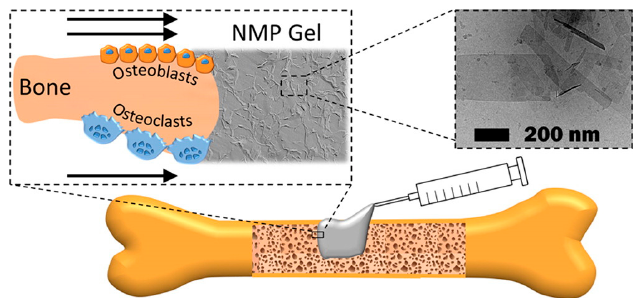
Figure 14. Schematic representation of a nanocrystalline magnesium phosphate (NMP) hydrogel and its application for bone repair. Image adapted with permission from reference [76]. Copyright 2016 American Chemical Society.